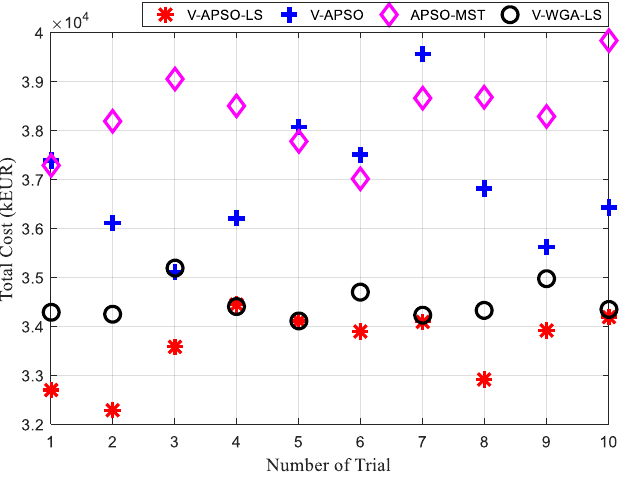
Figure 12. Ten trails for layout optimization of Model 2 obtained by V-APSO-LS, V-APSO, APSO-MST and V-WGA-LS.